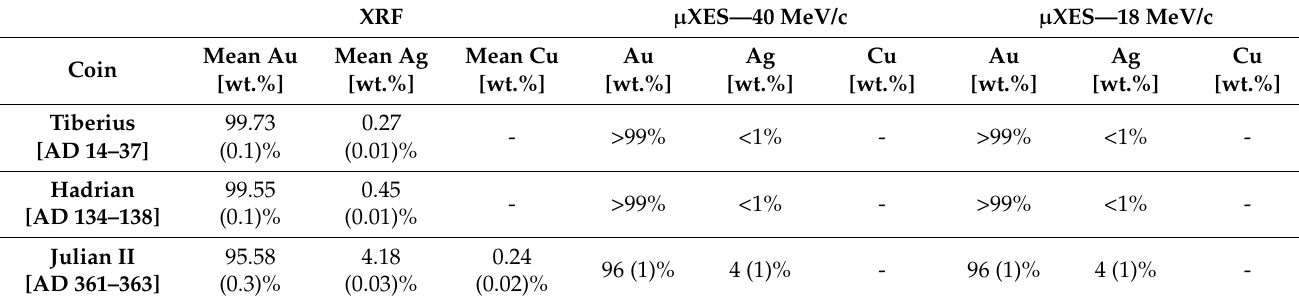
Table 2. Comparison of the XRF and Muon analysis. The results of the muon analysis are reported in the right columns. It is evident that the information coming from the surface (at 18 MeV/c) and the core (40 MeV/c) have no relevant difference: in this case, the surface is representative of the bulk composition. The data was taken from and adapted with permission from Ref. [37] © 2021, Elsevier Ltd. XRF µ XES—40 MeV/c µ XES—18 MeV/c